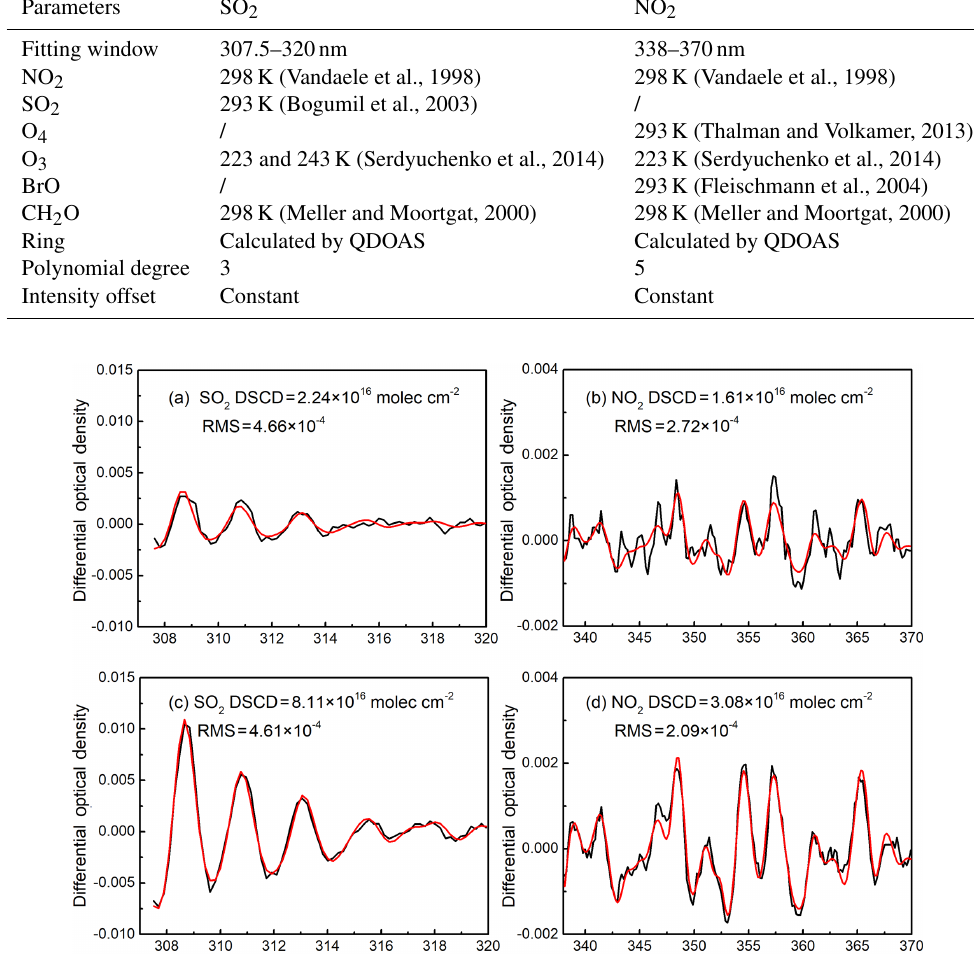
Figure 2. Typical DOAS spectral fitting for SO 2 and NO 2 . Panels (a) and (b) show spectrum collected at an elevation angle of 5 ◦ at 10:39LT on 22 June 2018 under clean conditions, whereas panels (c) and (d) are spectrum measured at an elevation angle of 5 ◦ at 09:53LT on 22 June 2018 under the influence of ship plume pollution. Black lines show the measured atmospheric spectrum, and the red line shows the reference absorption cross